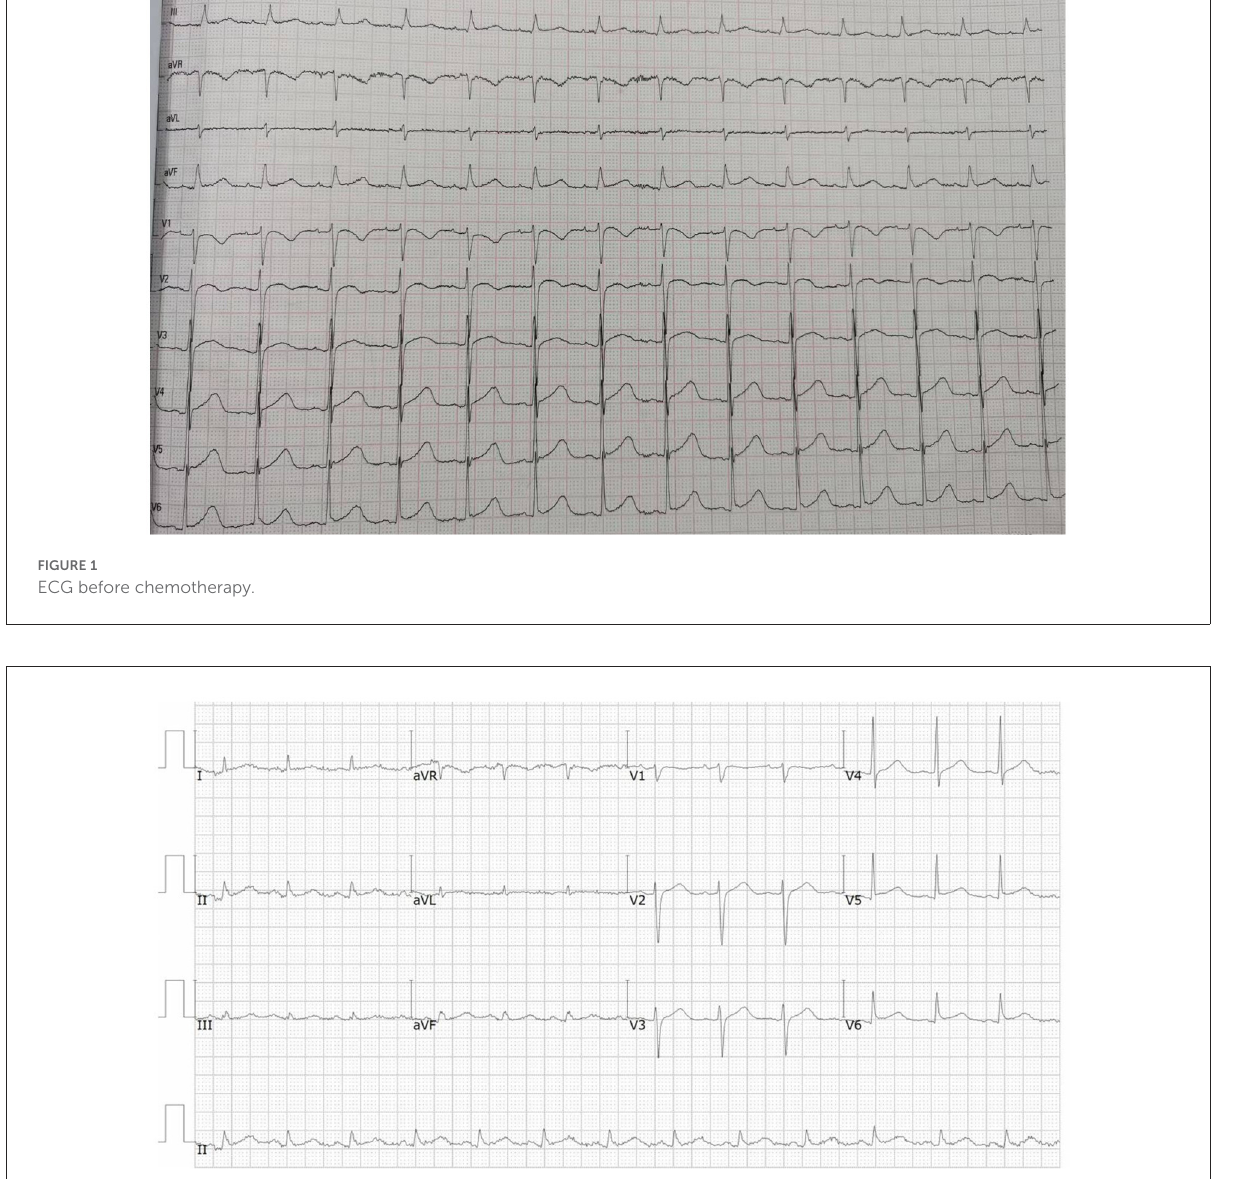
autoimmune or cardiovascular diseases. Cardiac screening tests including cardiac biomarkers, ECG (Figure 1), and echocardiography showed normal results before chemotherapy. The patient was treated with four cycles of albumin